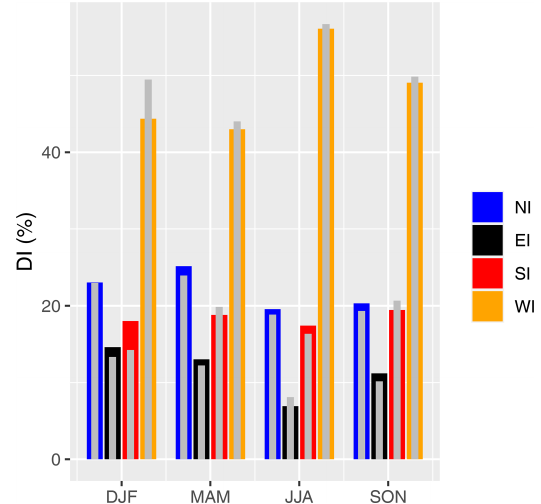
Figure 10. Seasonal frequencies of directional indices (DI: NI, EI, SI, and WI in percentage of nonmissing days) averaged for the pe- riod of 1665–1713 (color bars). Thin gray bars indicate the corre- sponding values for the 1981–2010 reference period (ERA5